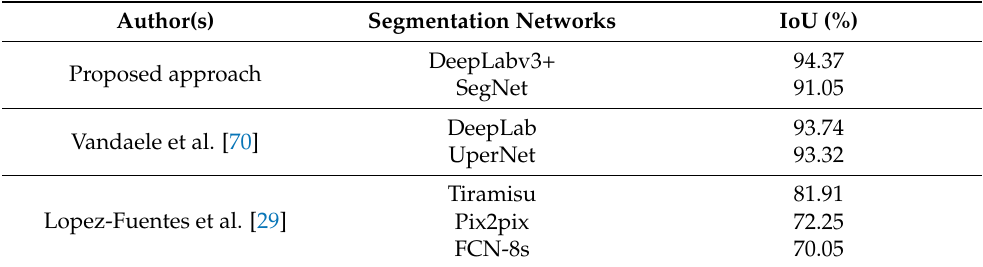
Table 2. A comparison between results from different segmentation networks used in this work and the previous